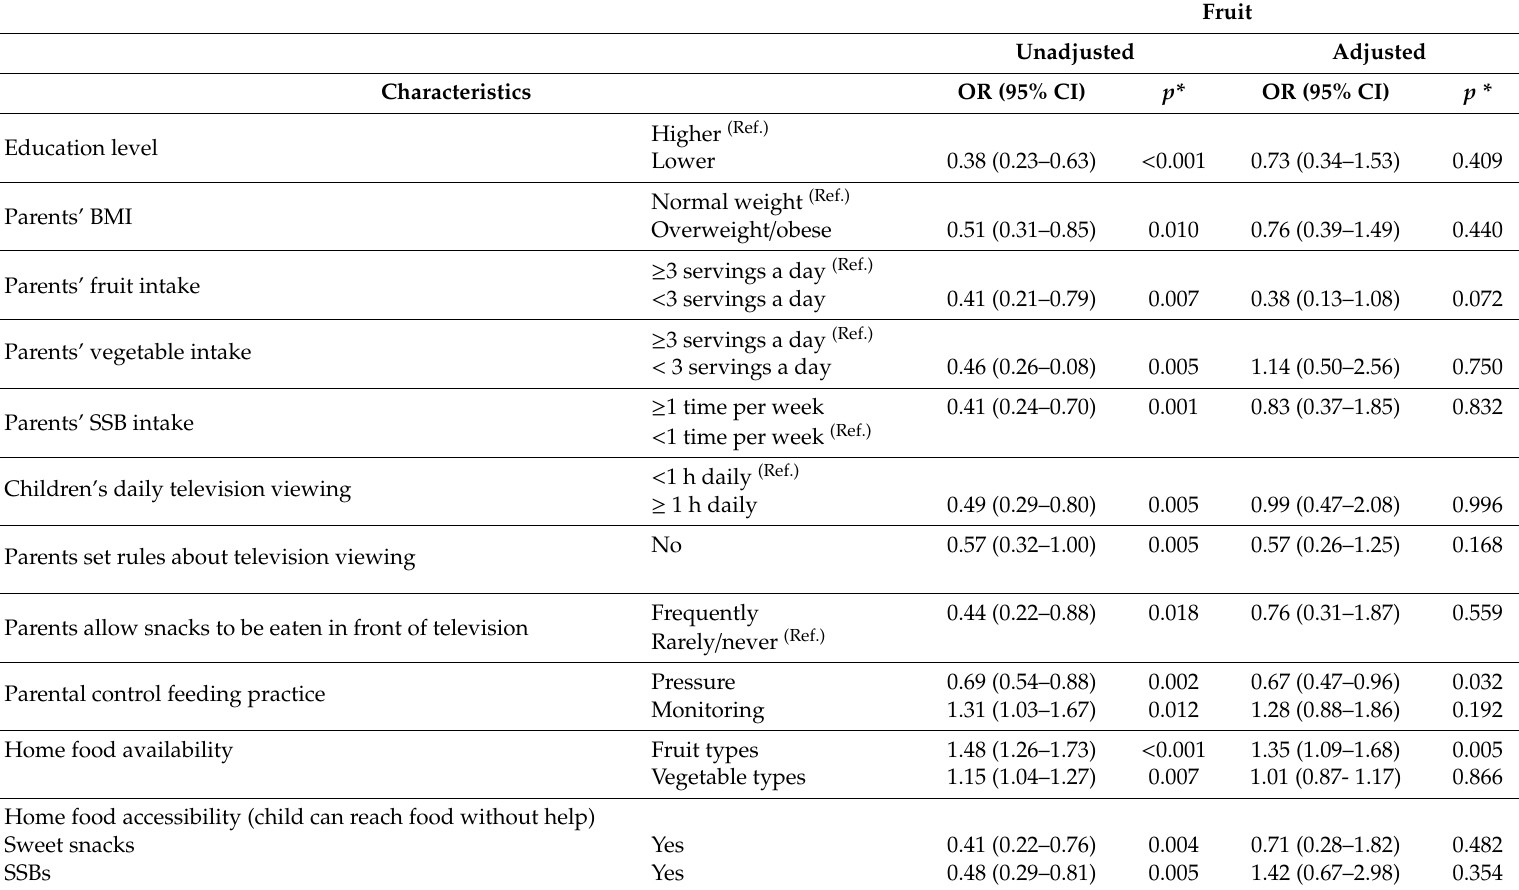
Table 4. Home environmental characteristics associated with children’s fruit